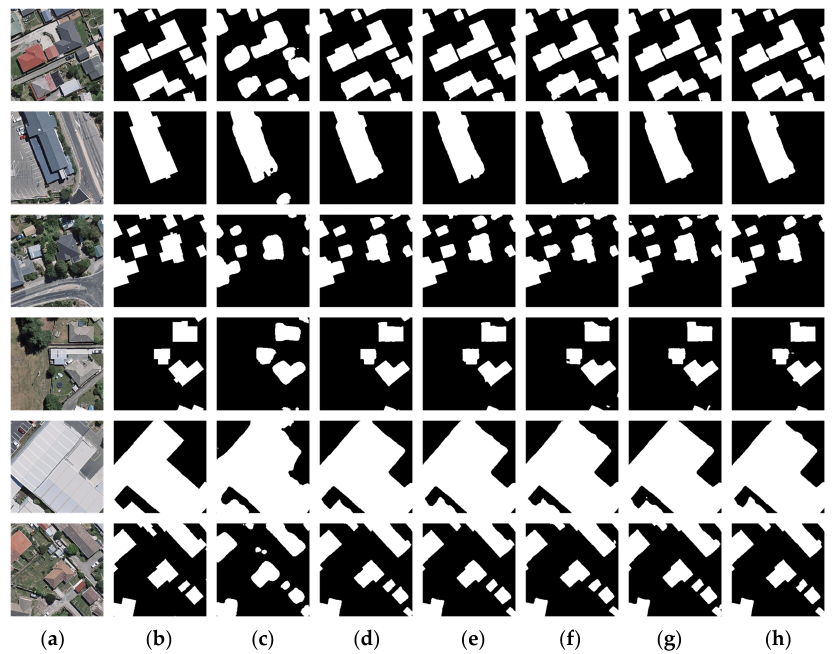
Figure 10. Segmentation results obtained by different image color translation methods on the Wuhan University building change detection dataset, ( a ) 2016 image, ( b ) 2016 ground truth, ( c ) Baseline, ( d ) HM, ( e ) Reinhard method, ( f ) DRIT, ( g ) UNIT, and ( h )